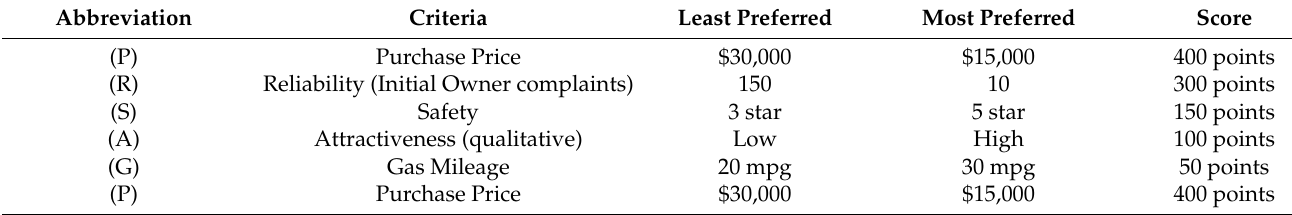
Table 1. Criteria for decision